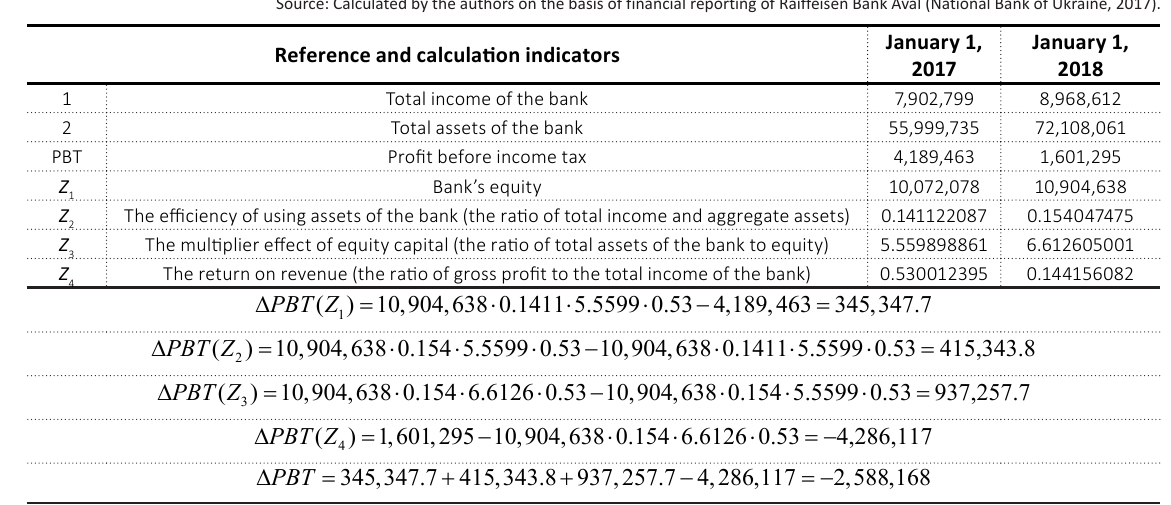
Table 6. Factor profit analysis of Raiffeisen Bank Aval